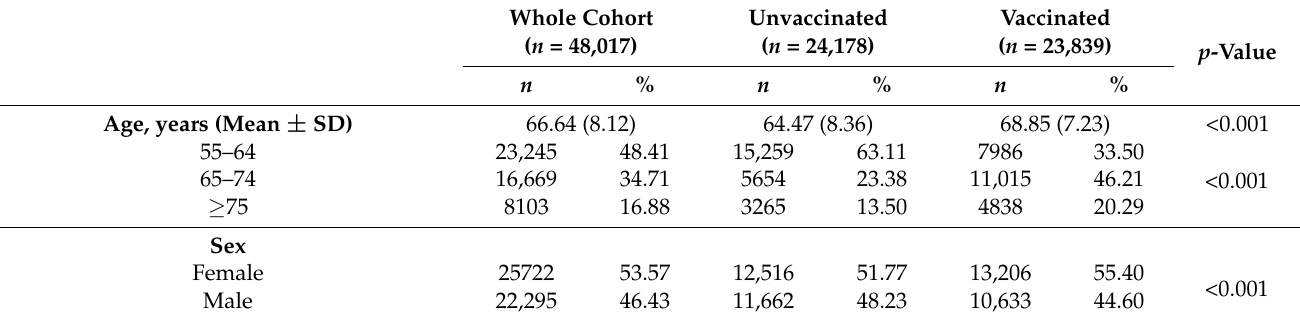
Table 1. Characteristics of the Sample